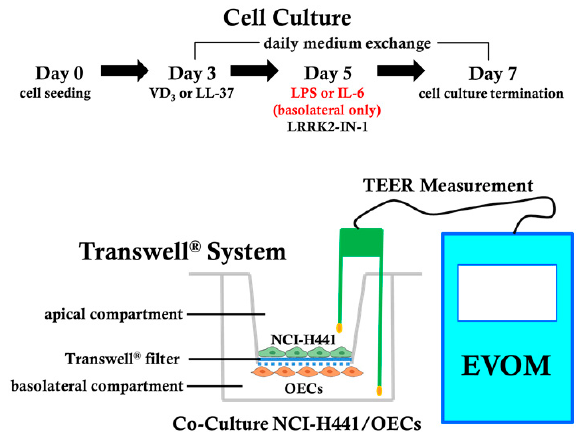
Figure 1. Experimental setup and design of the co-culture of NCI-H441/OECs in the Transwell ® systems for the TEER measurement.